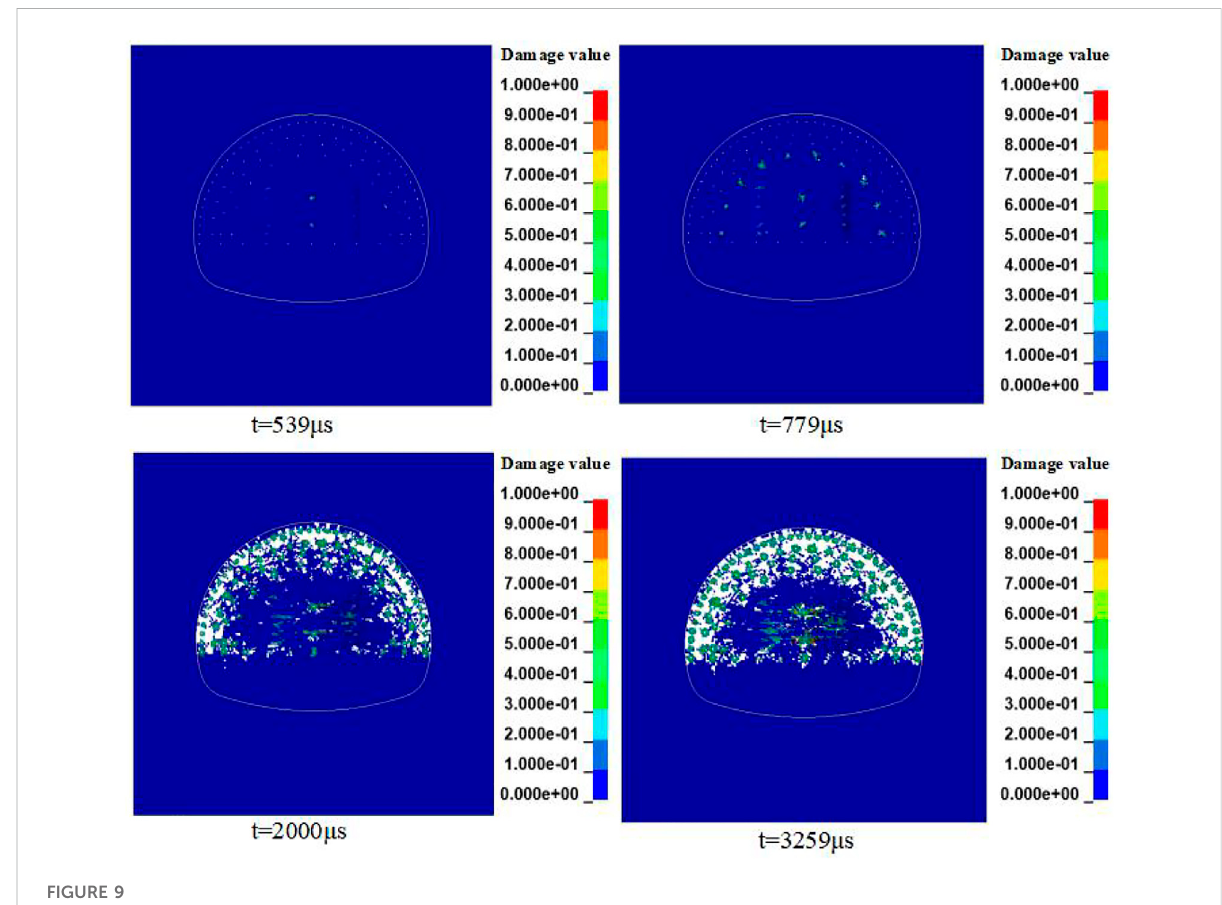
FIGURE 9 Formation process of a blasting